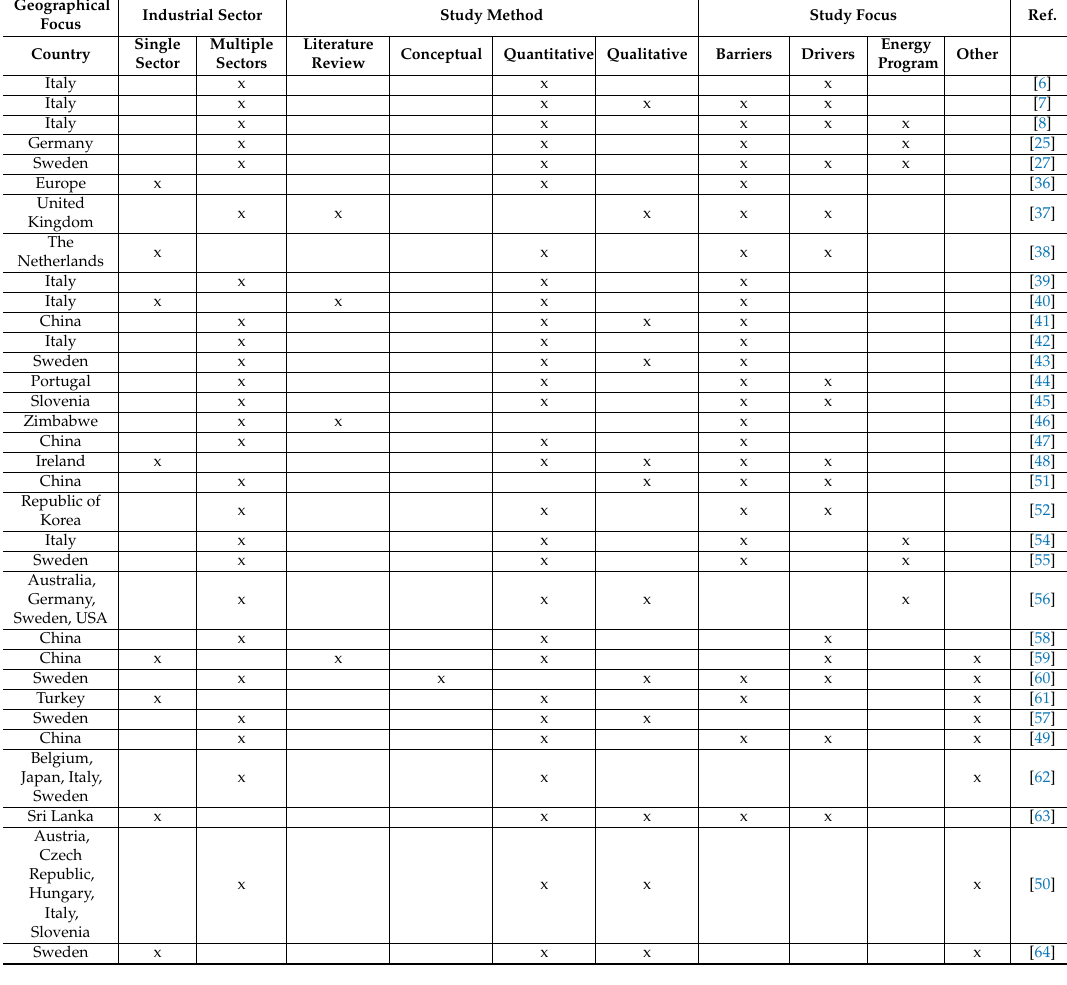
Table A1. Scientific journal publications on energy policies for improved energy efficiency for industrial SMEs.